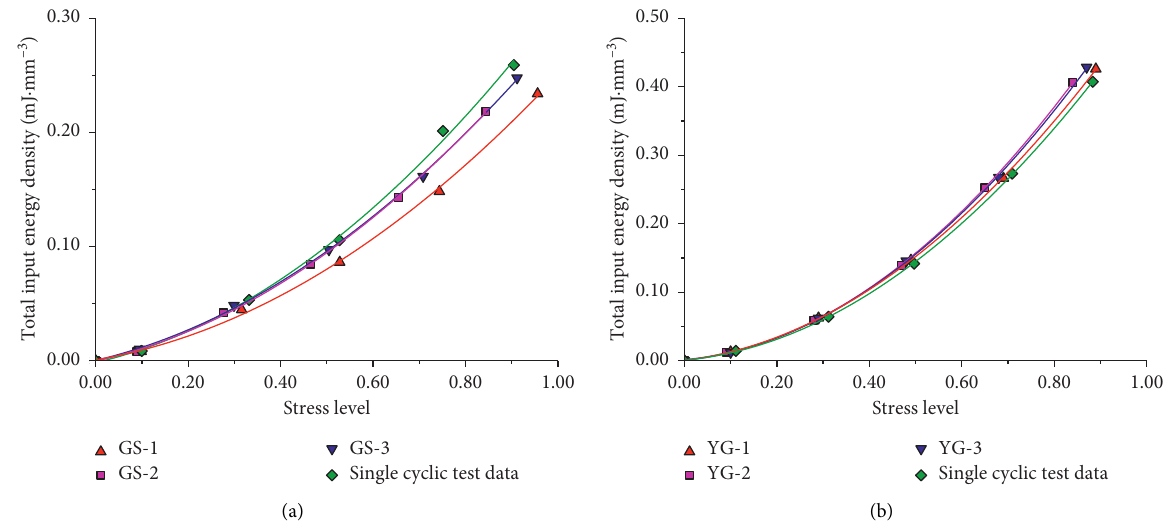
Figure 6: Variation tendency of the total input energy density with the stress levels in approach 1. (a) Green sandstone; (b) Yueyang granite.